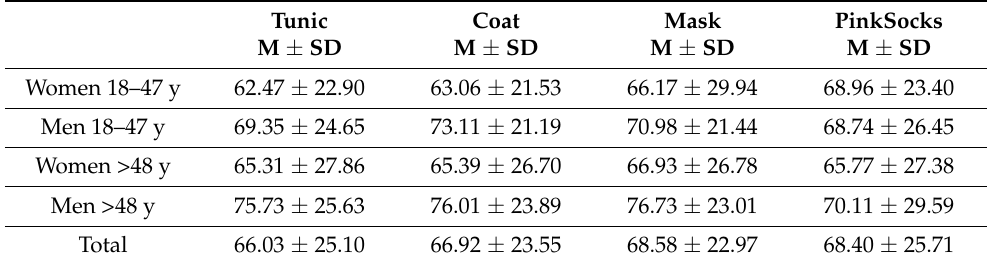
Table 4. Evaluation of the four photos according to choosing a practice (mean, standard deviation).